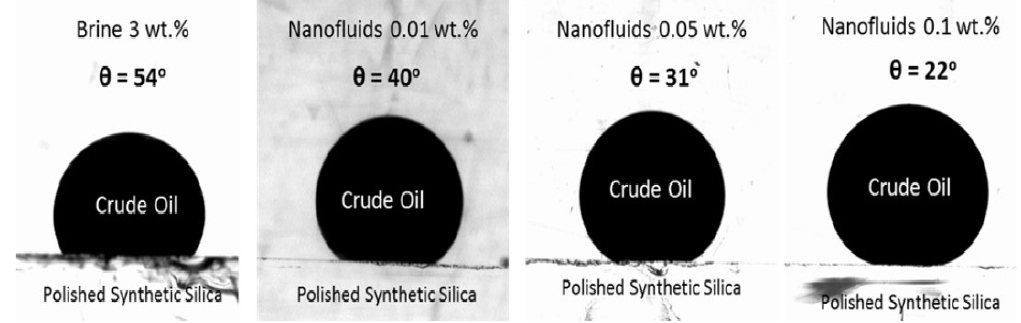
Figure 4. Contact angle variation of the oil-brine system in different concentrations. Reproduced with permission from reference [153]. Copyright 2013 Elsevier.